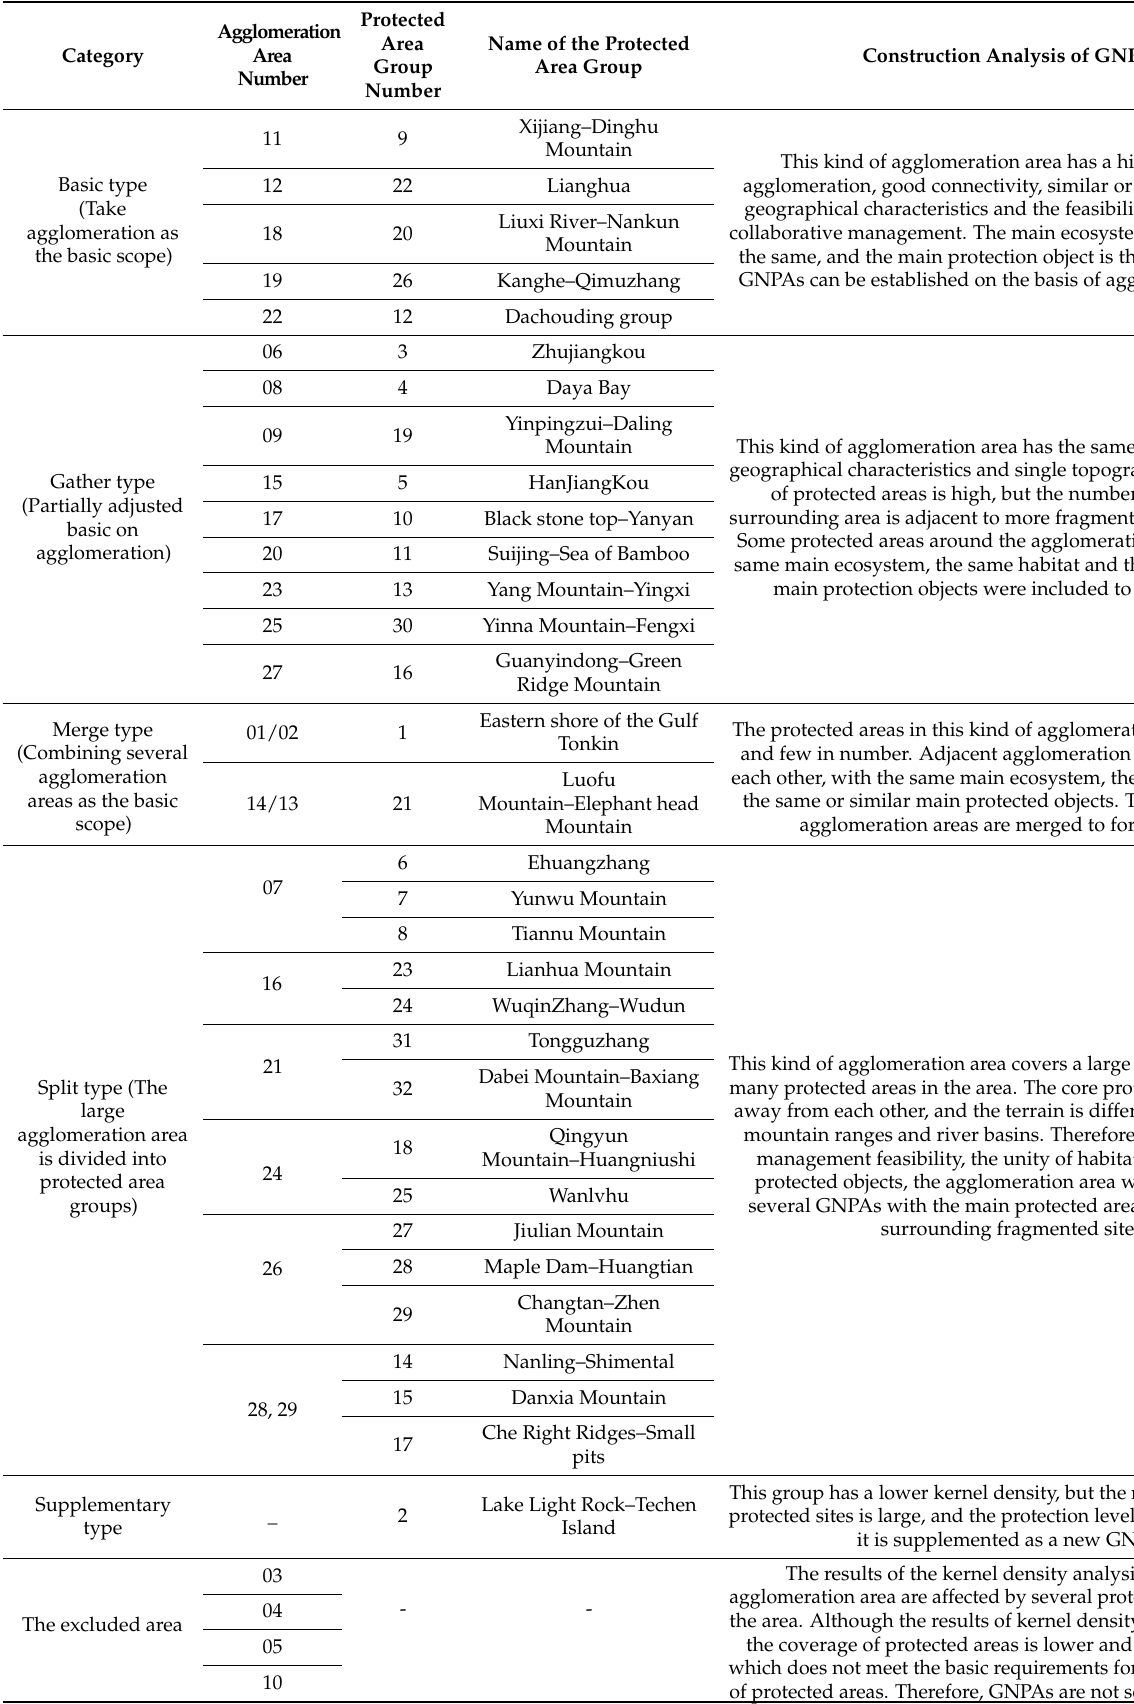
Table 5. Construction processes of